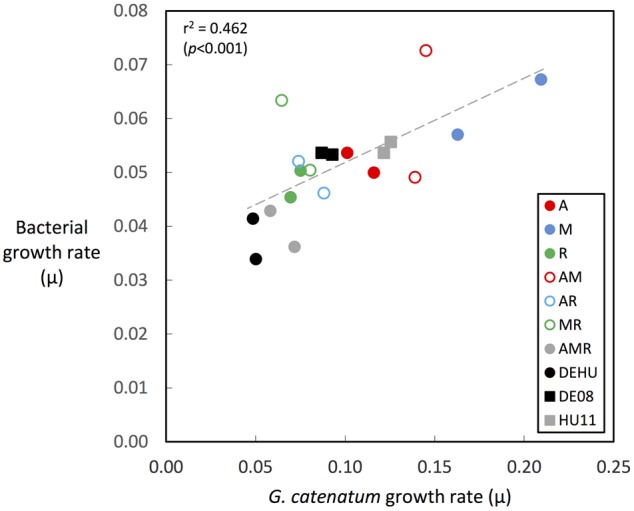
Correlation of bacterial associate and dinoflagellate growth rates during dinoflagellate exponential phase. Growth rates were calculated over exponential phase period in each culture as indicated by green-colored bars in Figures 2, 3 (circles = co-cultures, squares = parent cultures; see Table 1 for culture codes and additional detail).